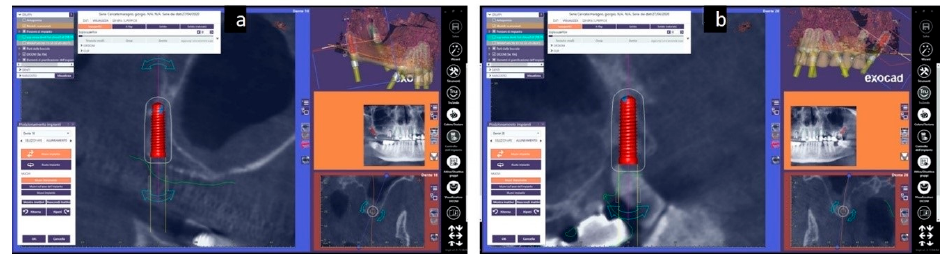
Figure 4. The digital planning of the right ( a ) and left ( b ) pterygoid implants position.